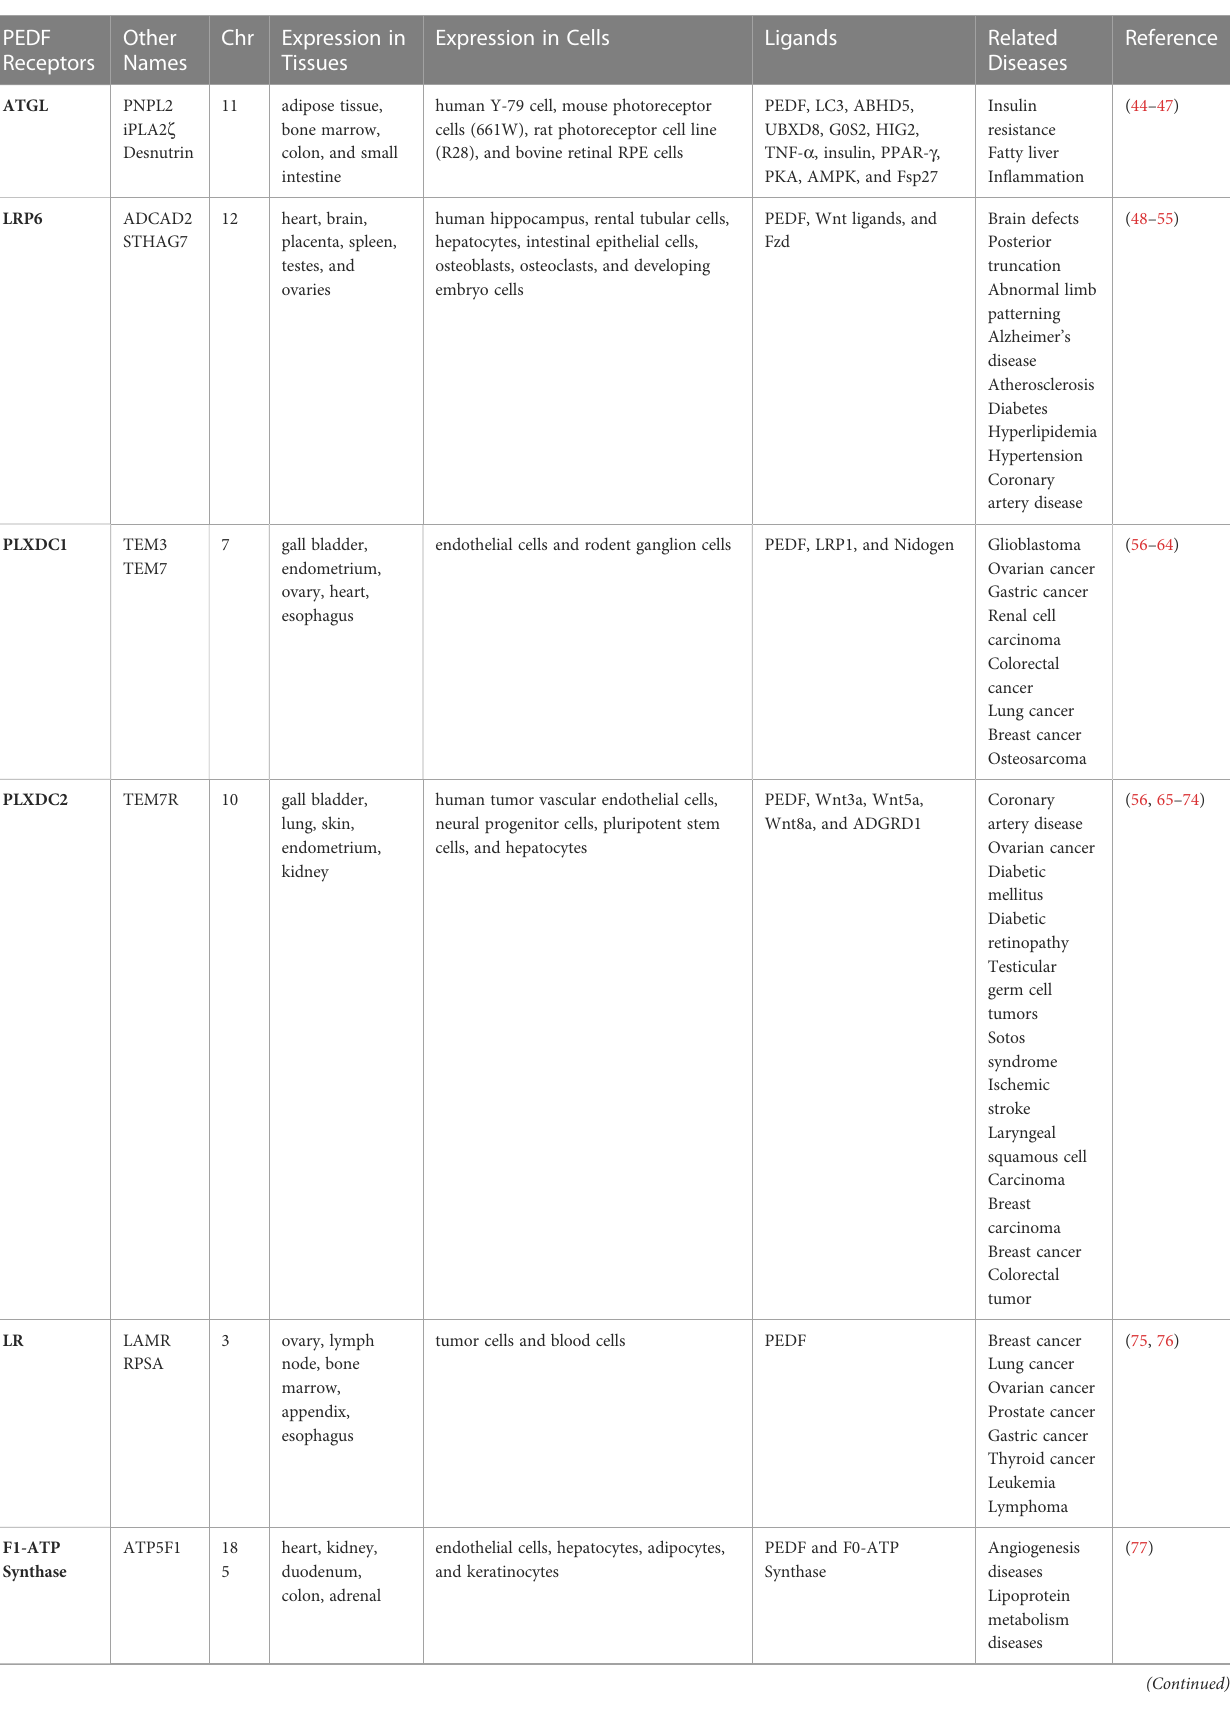
TABLE 1 PEDF receptor